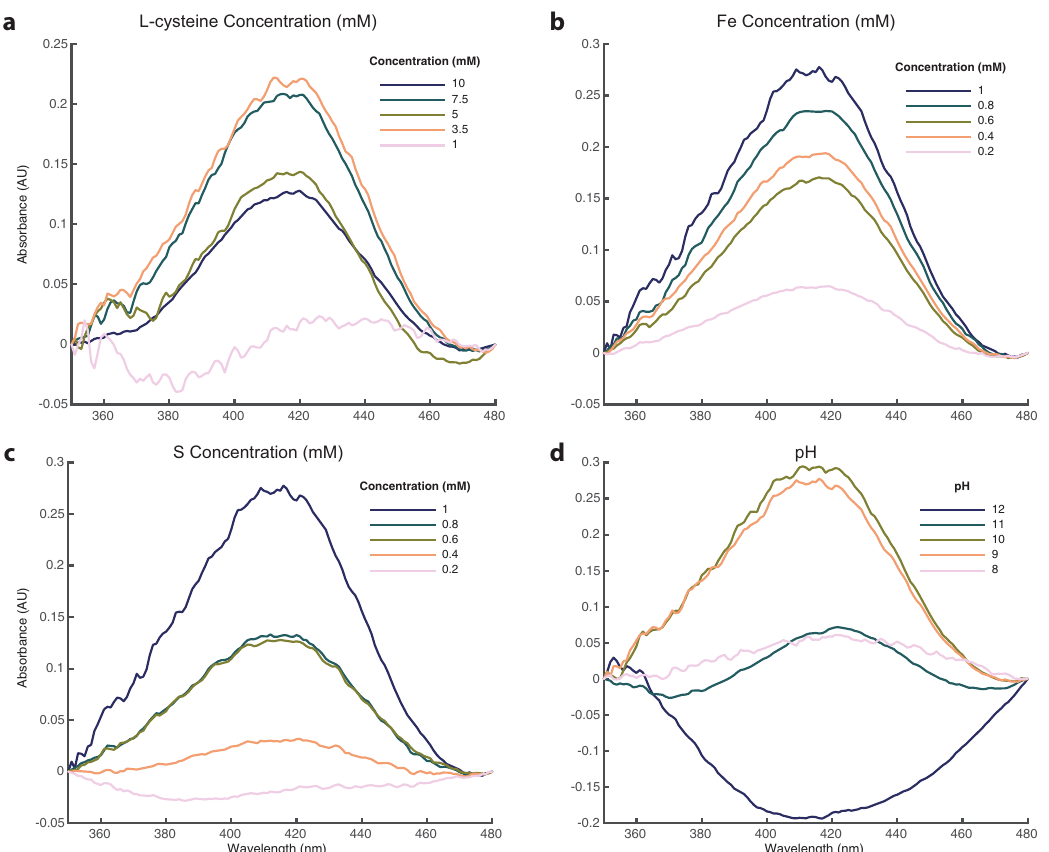
Fig. 4 FeS clusters form at low concentrations of all components and across a wide pH range. Extracted UV-Vis 420 nm peaks for pH 9 solutions prepared with a L-cysteine concentration ranging from 1 to 10 mM (concentrations of FeCl 3 and Na 2 S were both kept constant at 1 mM). b FeCl 3 concentrations ranging from 0.2 to 1 mM (L-cysteine and Na 2 S concentrations were constant at 5 and 1 mM, respectively). c Na 2 S concentrations ranging from 0.2 to 1 mM (L-cysteine and FeCl 3 concentrations were kept constant at 5 and 1 mM, respectively). d Extracted UV-Vis 420 nm peaks from solutions containing 5 mM L-cysteine, 1 mM FeCl 3 and 1 mM Na 2 S prepared at pH values ranging from 8 to 12. Source data are provided as a Source data fi